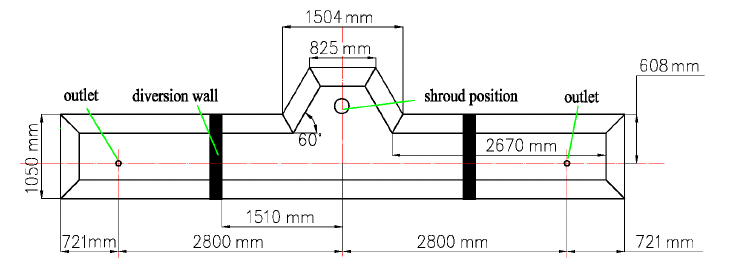
Figure 1. Schematic diagram of tundish vertical view.